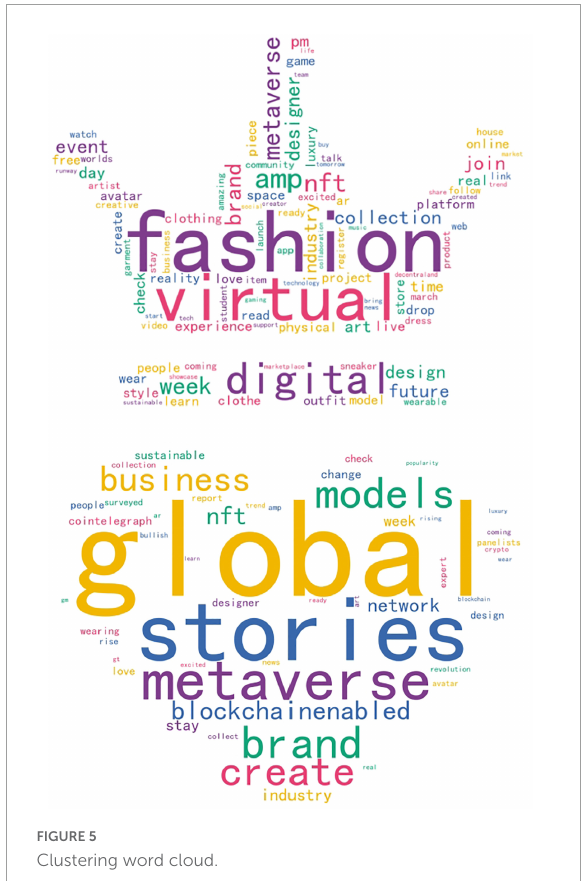
FIGURE5 Clustering word